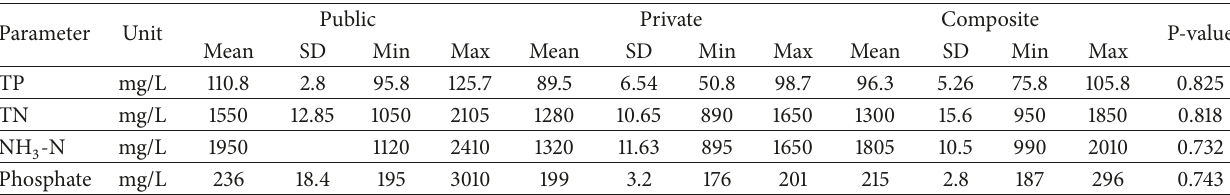
Table 2: Summary results for the nutrient composition of the faecal sludge.